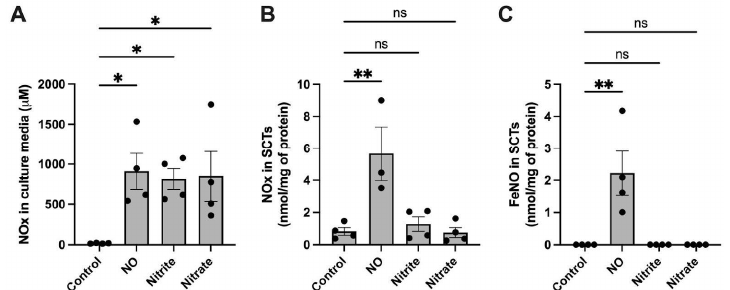
Figure 5. NO metabolism and FeNO formation in BeWo cell culture after 24 h of treatment with NO (as